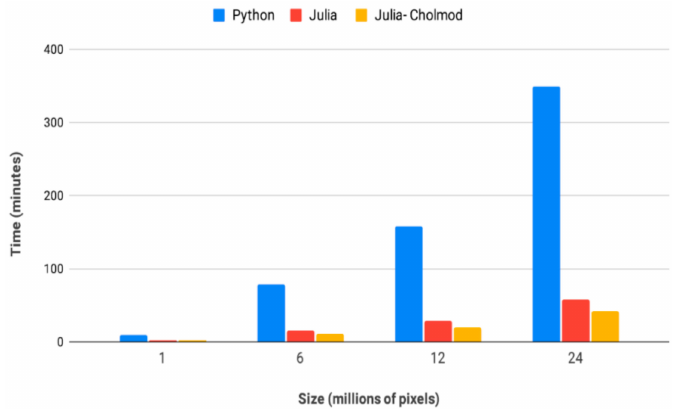
Figure 3. Reductions in solve time for Circuitscape 5.0 in Julia (red and orange bars) relative to Circuitscape 4.0.5 in Python (blue) on problem sizes ranging from 1 to 24 million pixels, run in pairwise mode with 153 pairwise solves, using 16 parallel processes. The two bars for the Julia version represent runs with the default solver CG + AMG (conjugate gradient algebraic multigrid) (red), and Suitesparse’s CHOLMOD solver (orange). Benchmarks were conducted on an Intel(R) Xeon(R) Silver 4114CPU @ 2.20 GHz with 384 GB of